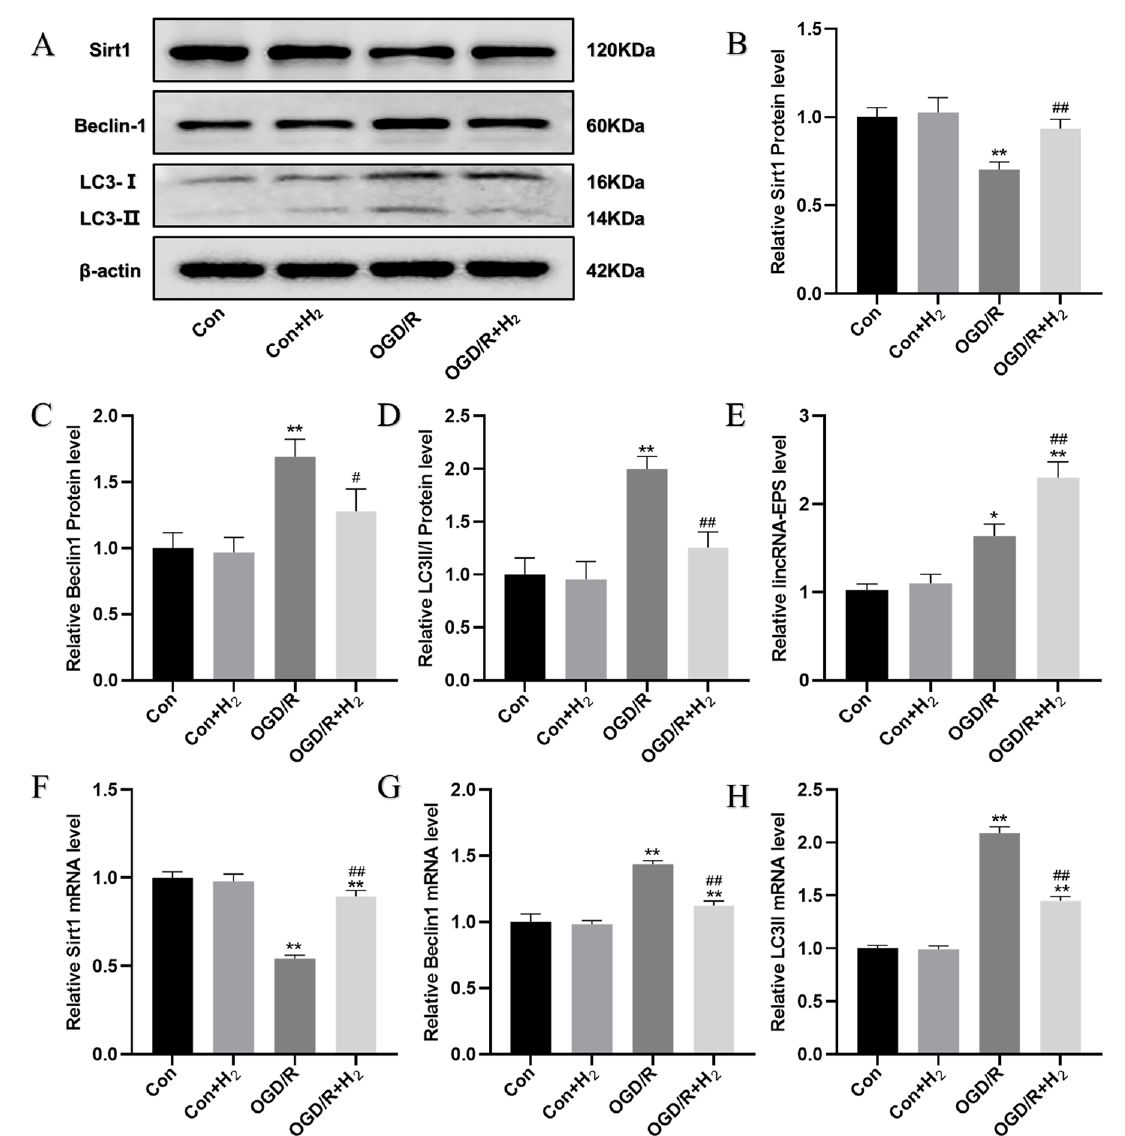
Figure 3. The possible protective mechanism of H 2 against neuronal OGD/R injury. ( A ) Sample bands from a Western blotting experiment. ( B – D ) Quantification of Sirt1, Beclin-1, and LC3-II proteins in each group, respectively. ( E ) The levels of lincRNA-EPS expression were upregulated by H 2 under OGD/R injury. ( F ) H 2 upregulated the mRNA level of Sirt1. ( G , H ). The mRNA levels of LC3-II and Beclin-1 per group. Data were displayed as mean ± SD. A minimum of three separate repetitions of the experiments produced similar results. * p < 0.05, ** p < 0.01 vs. Con group. # p < 0.05, ## p < 0.01 vs. OGD/R group.